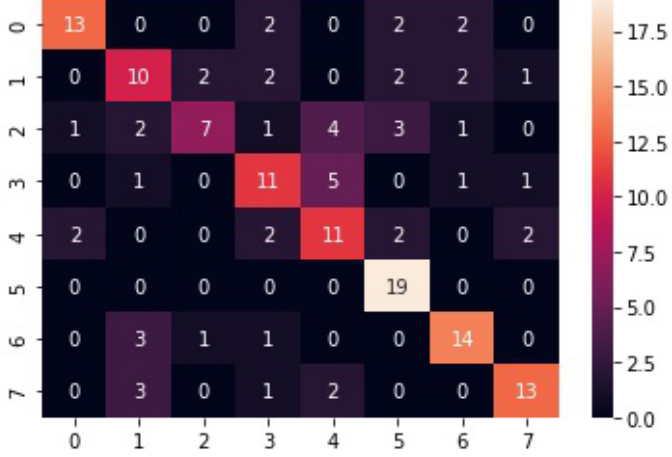
Figure 13. Decision-tree-based confusion